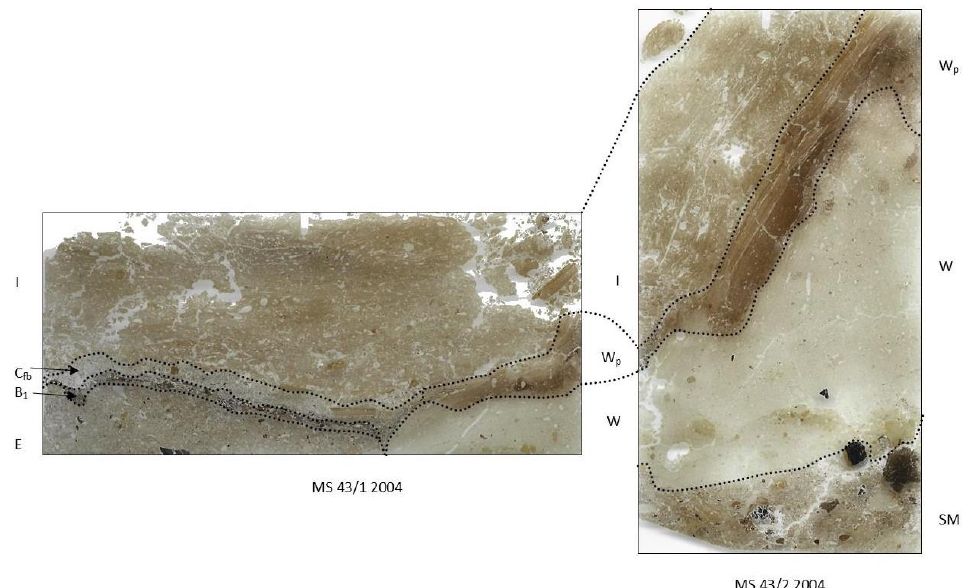
Figure 7. Thin section MS 43/1 2004 showing the ‘cleaning’ fire and thin section MS43/2 2004 showing the burnt wall of house ID 3497.